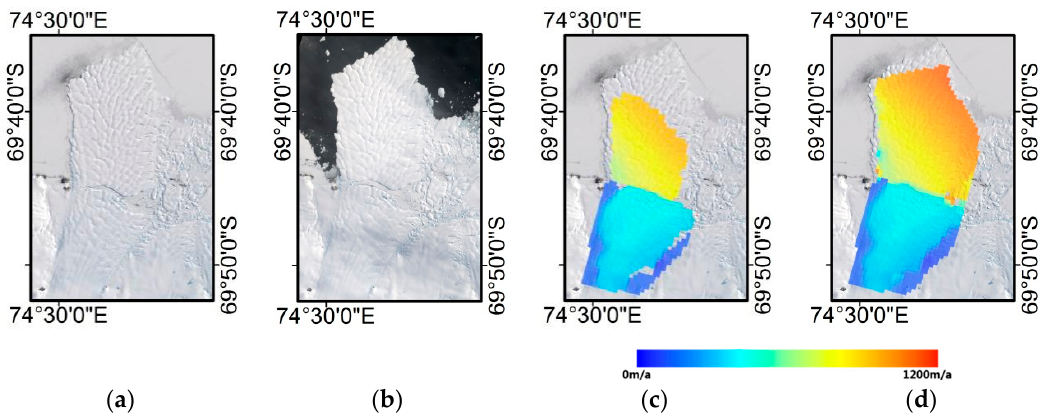
Figure 2. Ice velocity maps for the Polar Times Glacier. ( a ) Master image from February 2005; ( b ) Slave image from February 2006; ( c ) Ice velocity results obtained using the traditional NCC-based feature-tracking method; ( d ) Ice velocity results obtained combing the traditional NCC-based feature-tracking method, the rotation-invariant feature-tracking method.